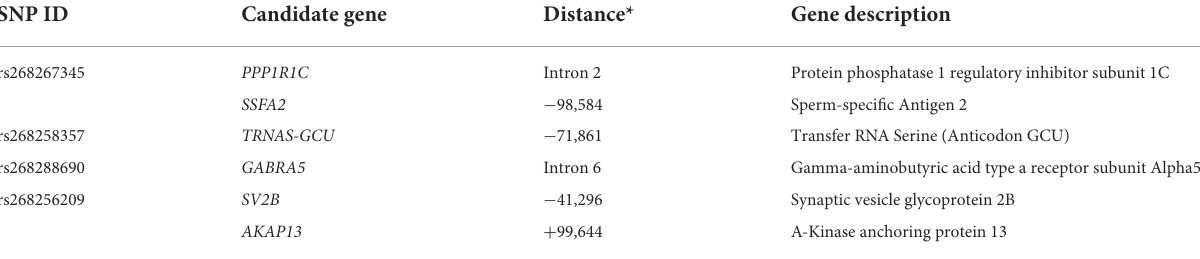
TABLE 5 Genes within 100kb distance from identified significant SNPs and their description. SNP